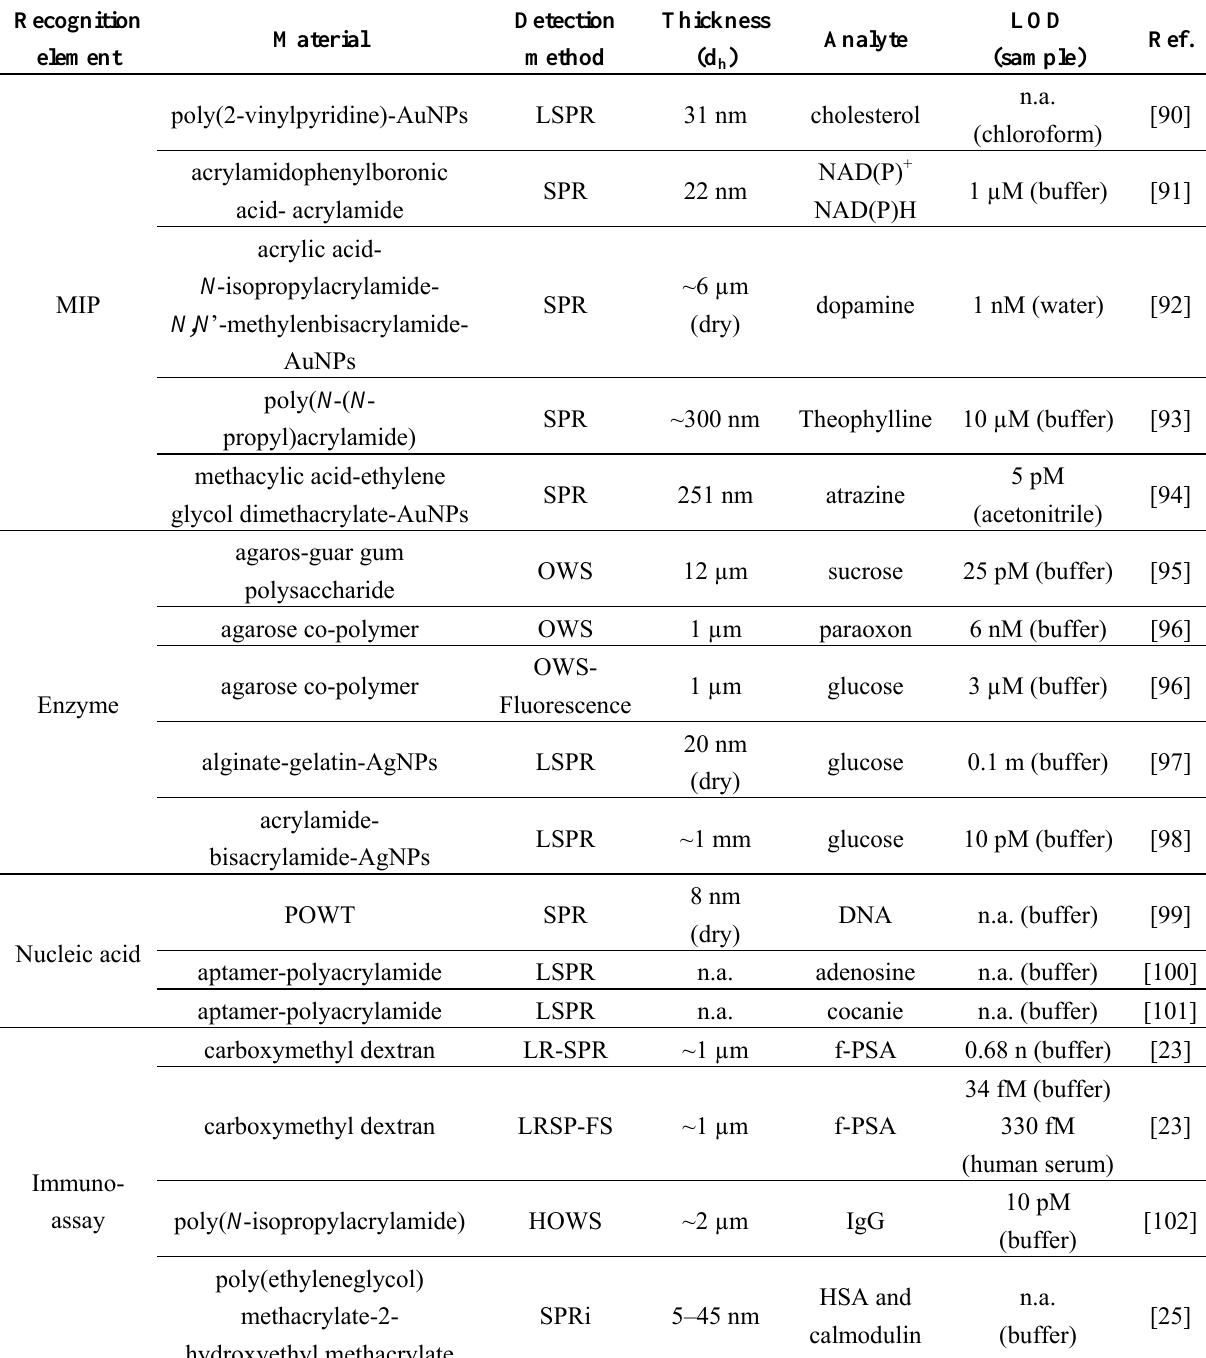
Table 1. Overview of hydrogel biosensors based on evanescent wave